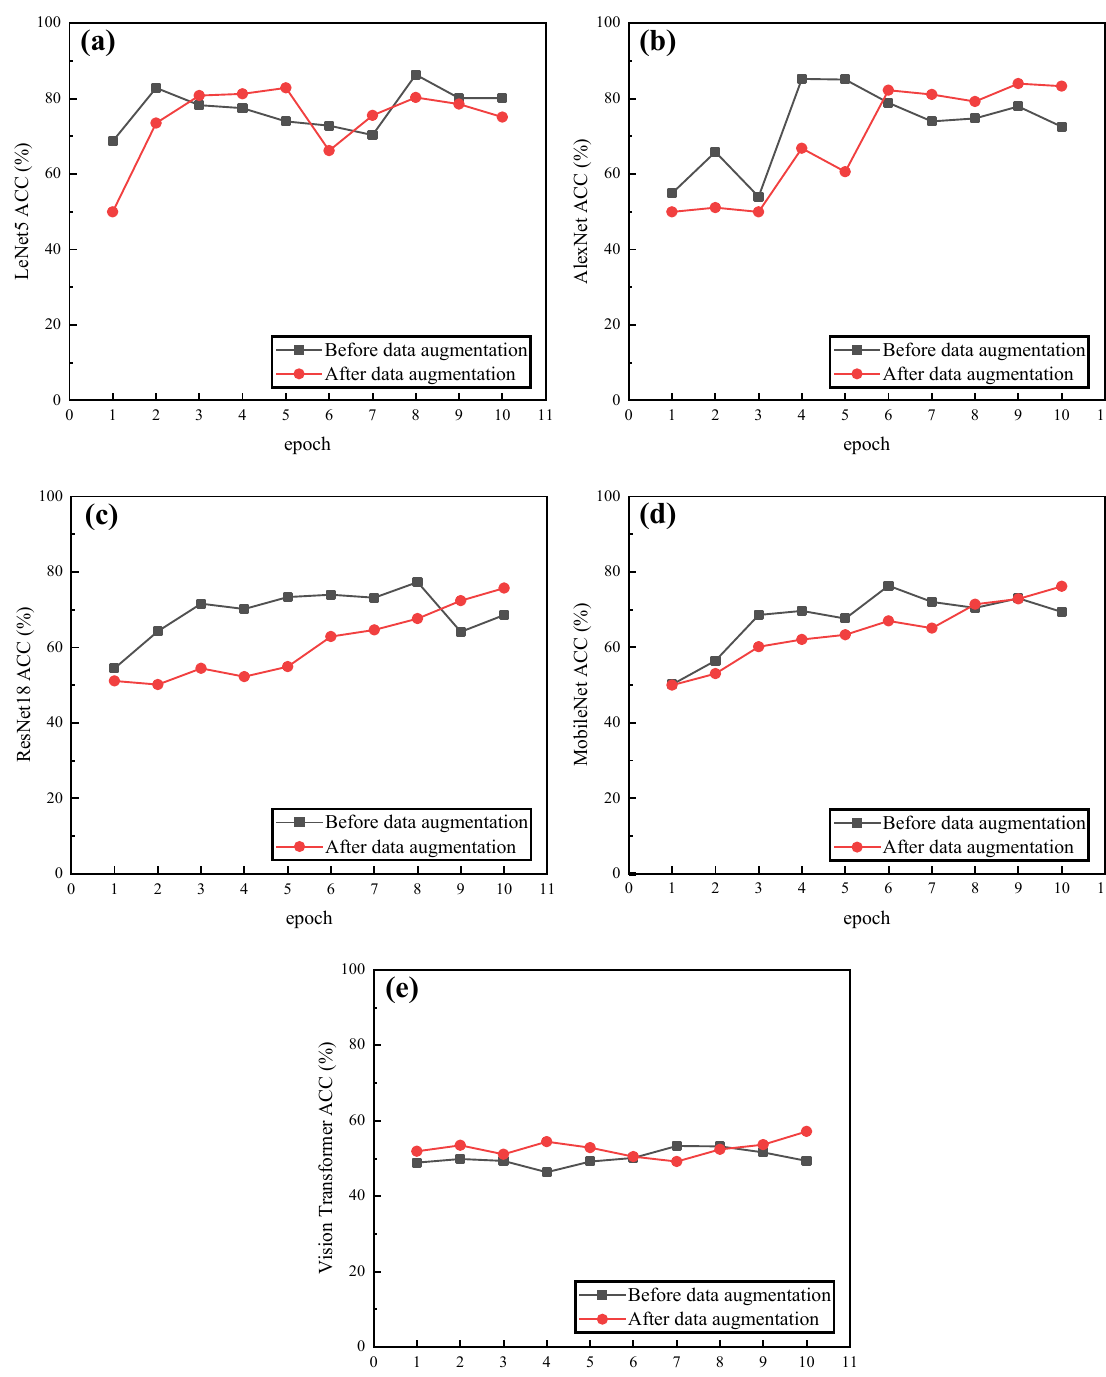
Figure 12. Comparison of accuracy of each model before GPU loading before and after data aug- mentation. ( a ) Comparison of the accuracy of LeNet5 model. ( b ) Comparison of the accuracy of AlexNet model. ( c ) Comparison of the accuracy of ResNet18 model. ( d ) Comparison of the accuracy of MobileNet model. ( e ) Comparison of the accuracy of Vision Transformer